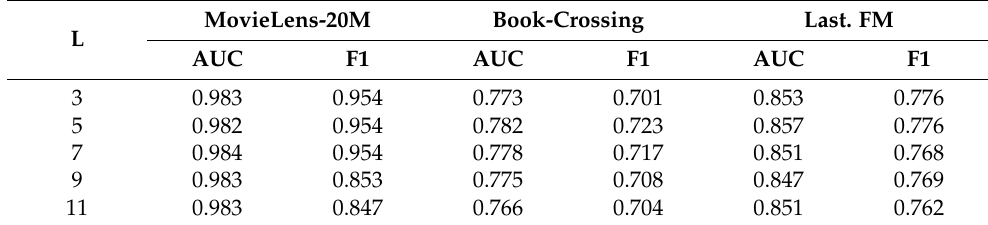
Table 7. Experimental performance of ATKGRM with different L